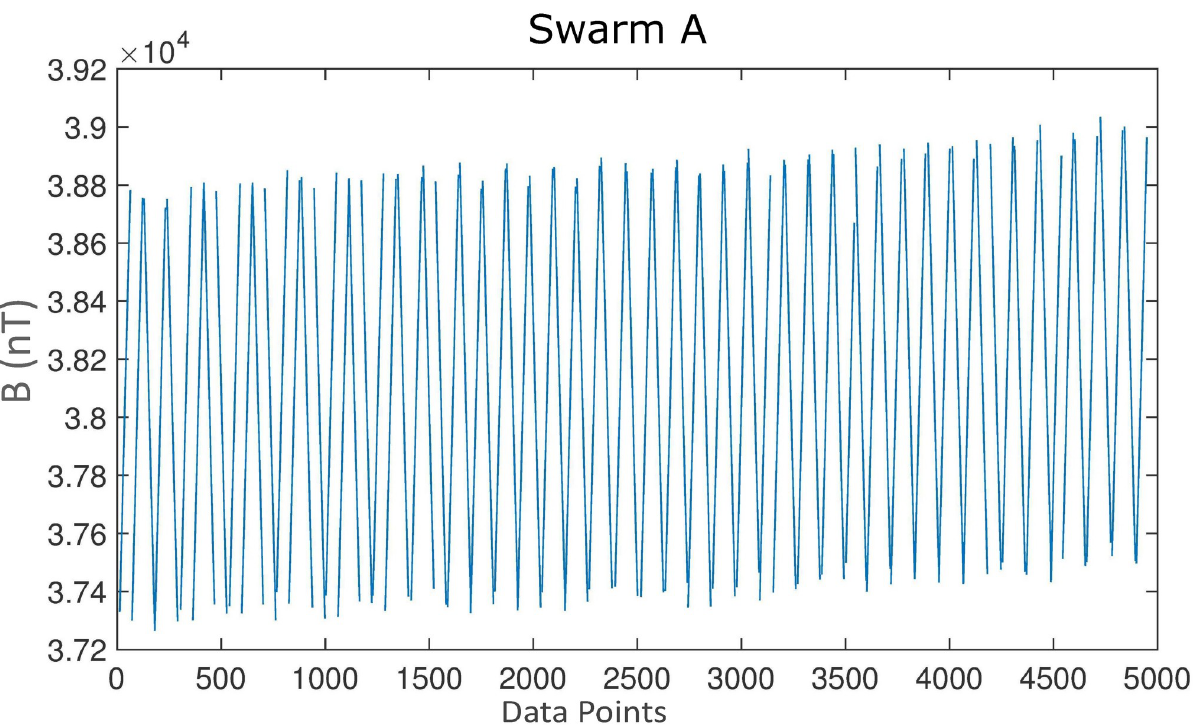
Fig 2. Raw data before pre-processing and magnetic field